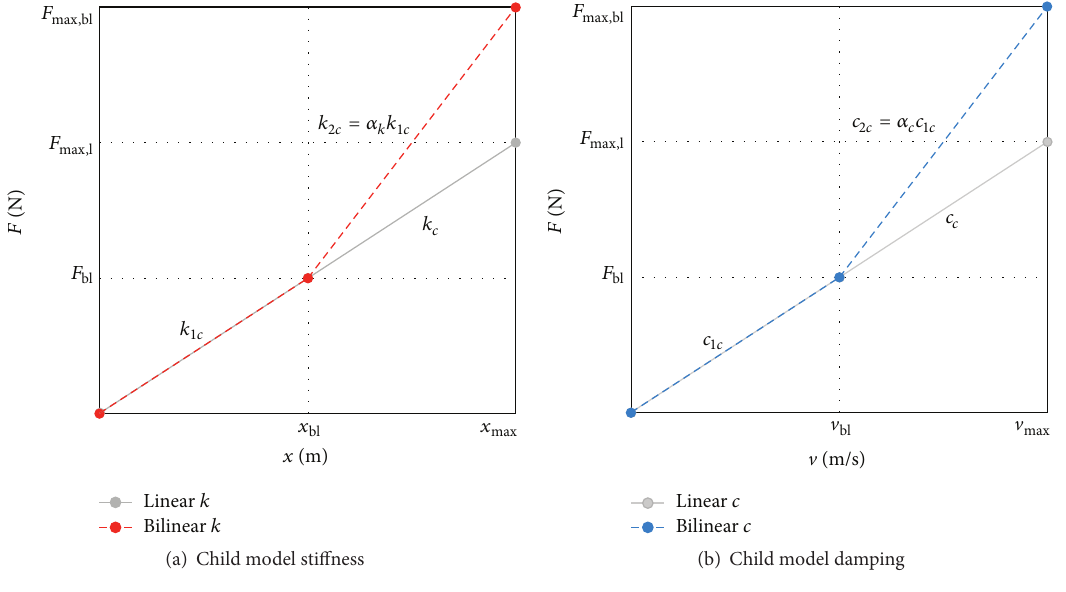
Figure 4: The stiffness (a) and damping (b) of the child